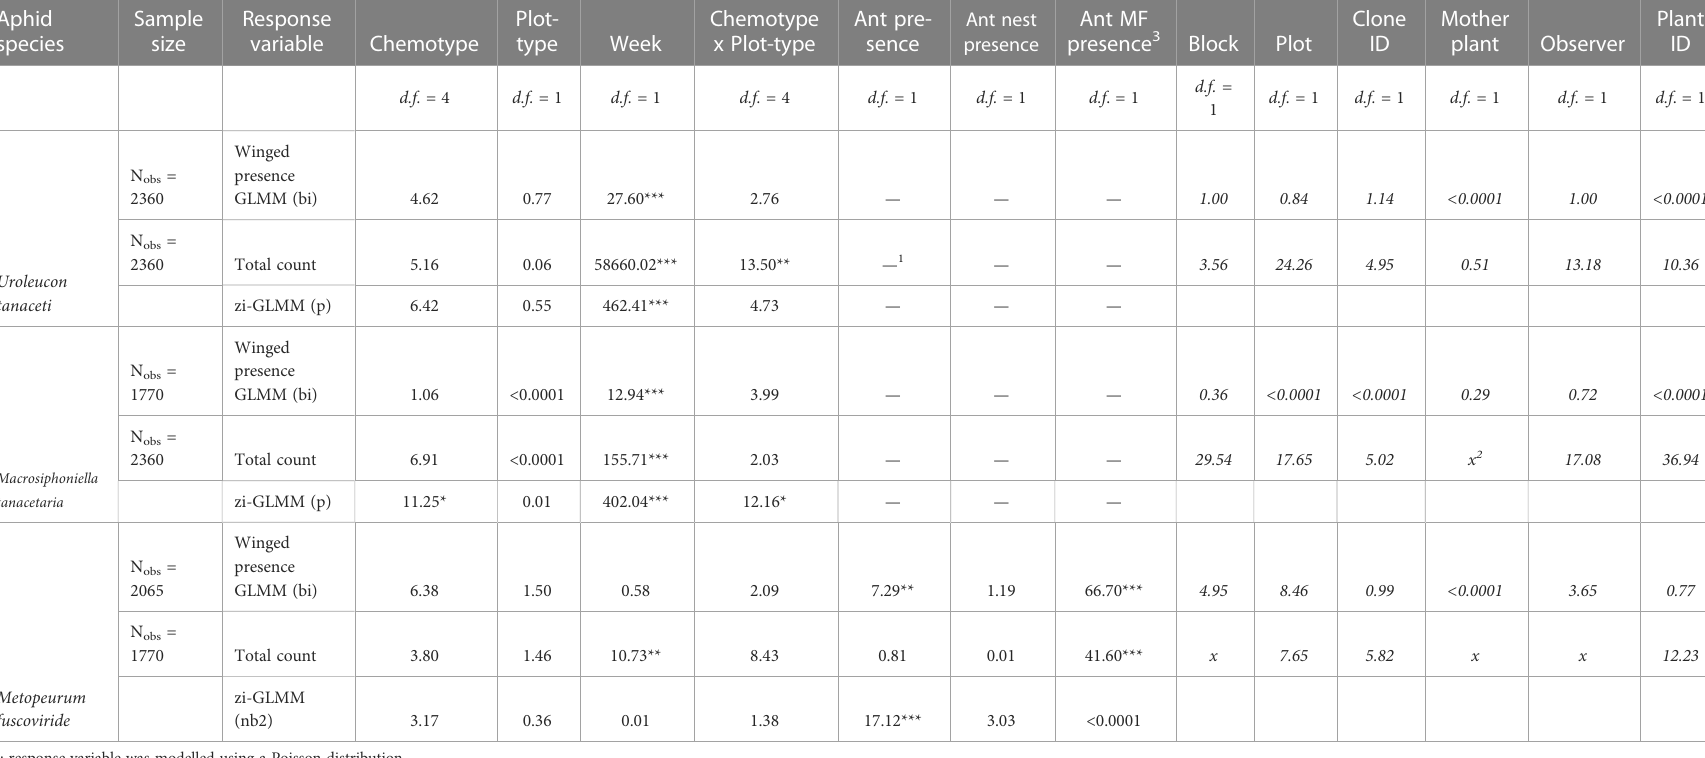
TABLE 1 (zi-)GLMM estimates of total count (unwinged and winged aphids) and presence of winged morphs of three aphid species specialised on Tanacetum vulgare across the counting season.